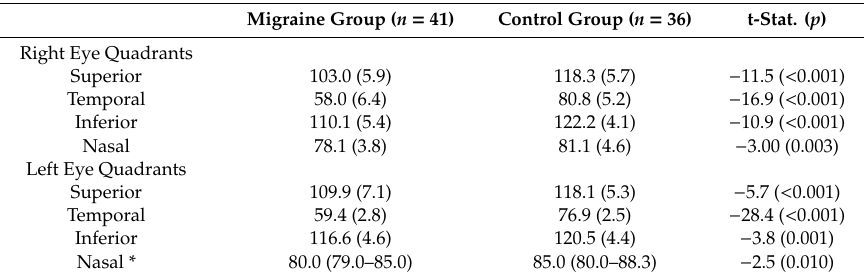
Table 2. Peripapillary retinal nerve fiber layer thickness ( µ m) by groups.